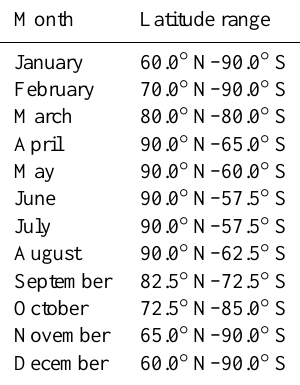
Table 2. Latitudinal and monthly constraints imposed on the GTO- ECV CCI monthly mean